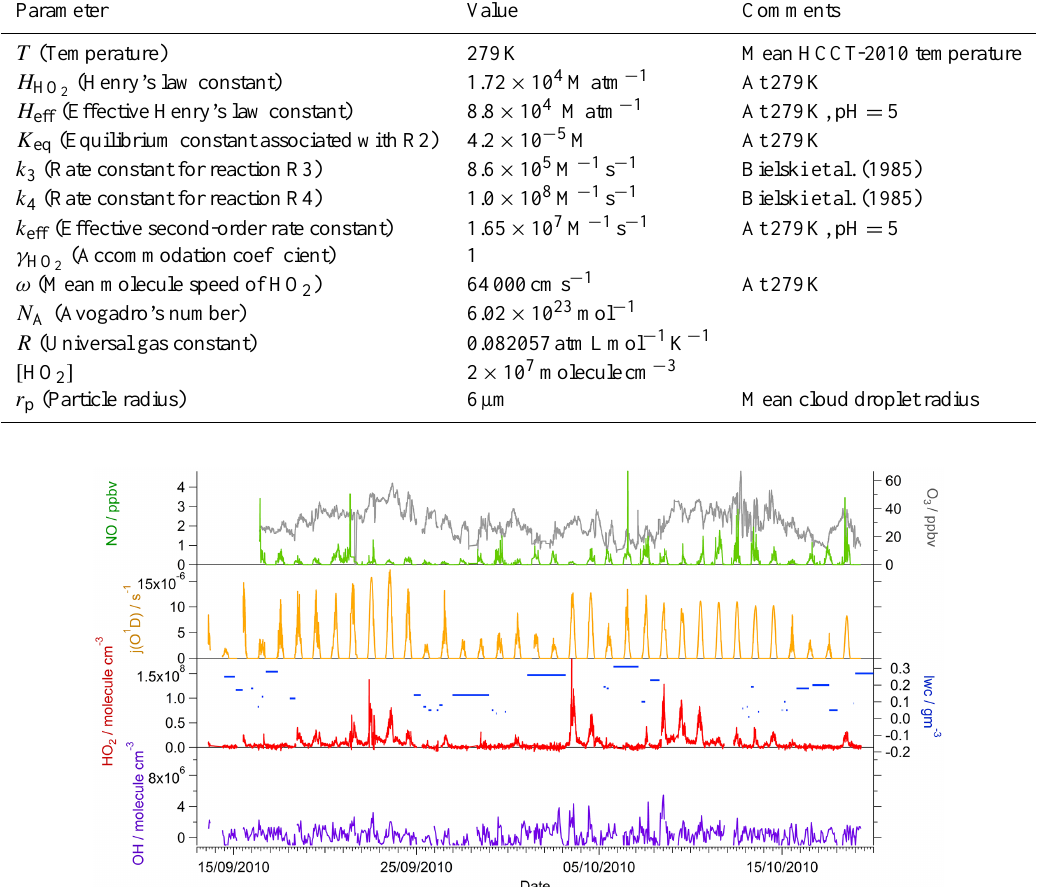
Figure 2. Time series showing the average liquid water content during each cloud episode (blue, horizontal lines), [OH] (purple), [HO 2 ] (red), j (O 1 D) (orange), NO (green) and O 3 (grey). All data are the average concentrations determined for each FAGE data acquisition cycle, apart from OH concentrations, which are